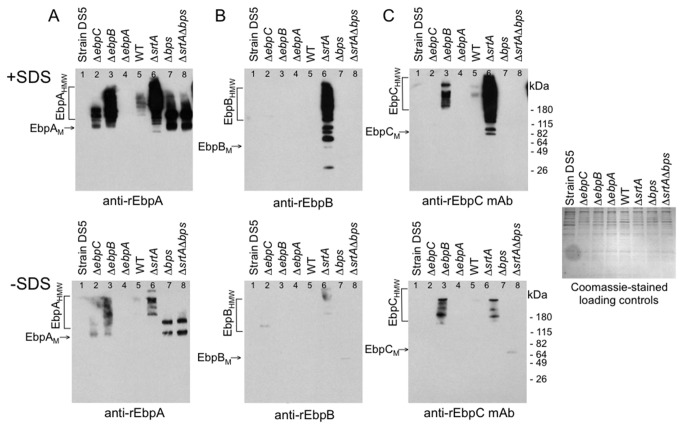
Release of surface-associated Ebp proteins from E. faecalis cells by a mild (0.5%) SDS treatment.Western blots of SDS extracts from exponential cells (see text for details) of strain OG1RF and its deletion derivatives and strain DS5. (A) Immunoblot stained with polyclonal anti-EbpA antibodies. (B) Immunoblot stained with polyclonal anti-EbpB antibodies. (C) Immunoblot stained with monoclonal anti-EbpC antibodies. (D) Coomassie staining of the above SDS extraction samples; sample order as in panels A, B and C. EbpAM, EbpA monomer; EbpAHMW, high molecular weight EbpA polymers. +SDS, extraction with SDS; -SDS, extraction without SDS. Positions of molecular weight markers are indicated.